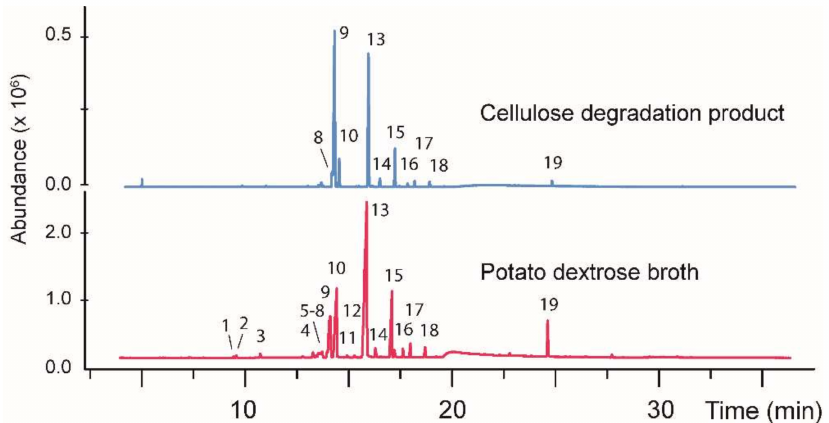
Figure 1. A gas chromatogram showing the volatile organic products produced by the fungus CI-4 growth on a conventional media ( bottom ) versus a diet containing carbohydrates produced from cellulose degradation ( top ). The nominal masses for each numbered peak are given in Table 2. In each case a control sample was also analyzed consisting of the growth medium without fungi added. This solution was processed identically to the fungi-containing samples. In each case, no peaks from the control samples corresponded to any of the peaks shown